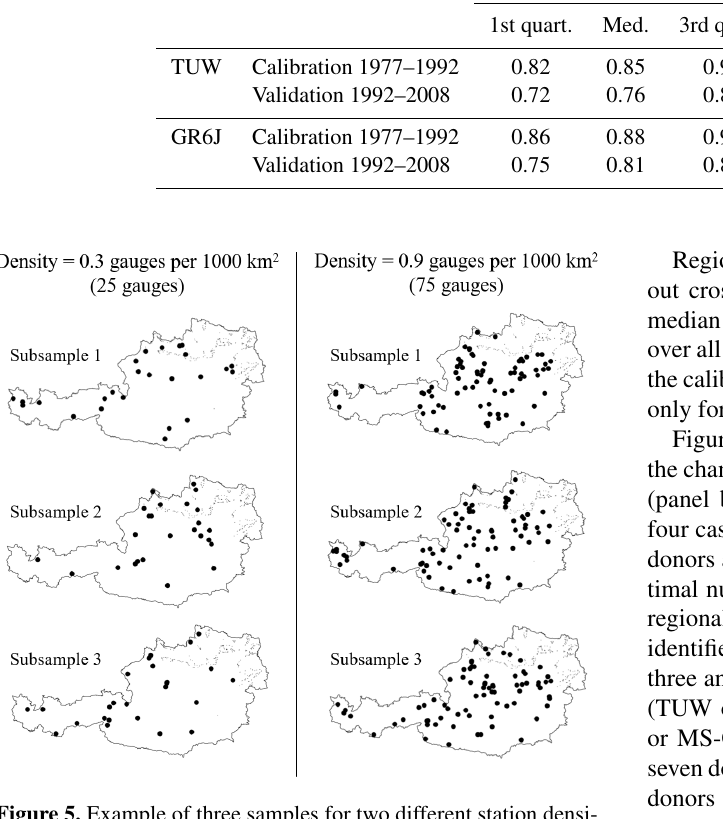
Figure 5. Example of three samples for two different station densi-